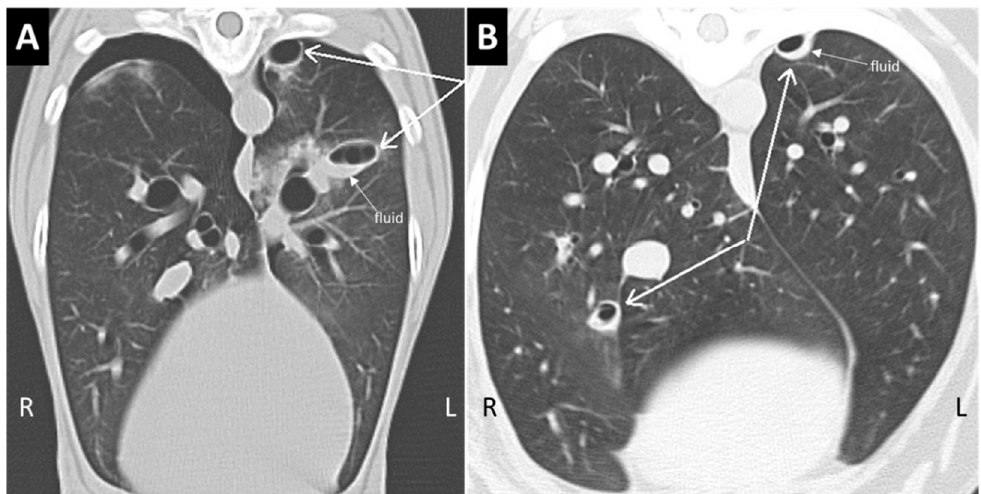
Figure 3. Type 1 and Type 2 lung lacerations. ( A ) The transverse section of the thorax in a traumatized